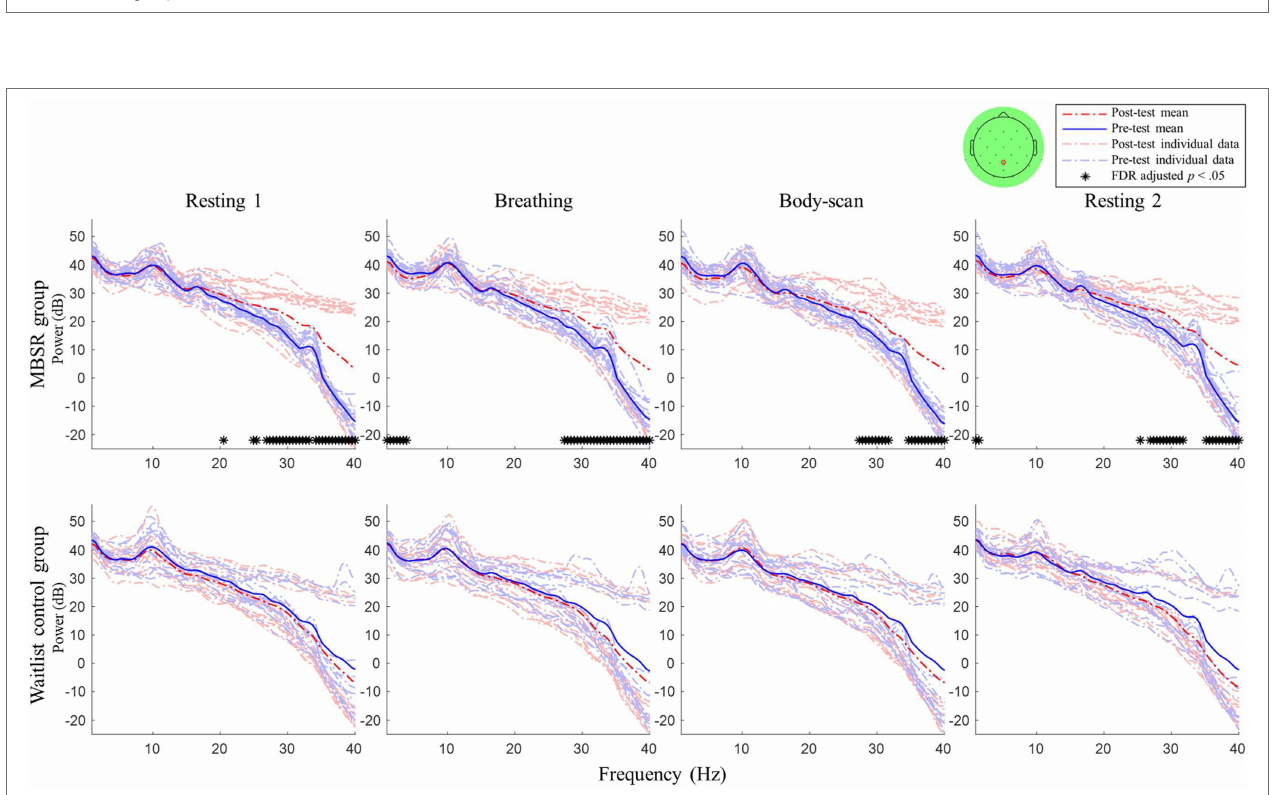
FIGURE 2 | Post–pre-test PSD t- test for channel Fz between the mindfulness-based stress reduction (MBSR) group and waitlist control. MBSR group n = 17, waitlist control group n = 14.